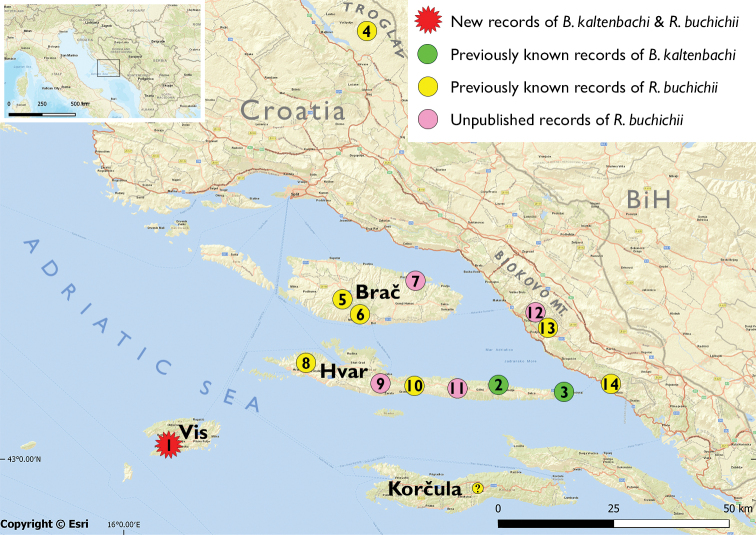
Distribution of the only known endemic bush-crickets (Tettigoniidae) of Croatia: Barbitistes
kaltenbachi (localities 1–3) and Rhacocleis
buchichii (localities 1, 4–14, ?) 1 new records from Vis Is., Mt. Hum (present paper) 2 Hvar Is., Likova Glava, Bogomolje (present paper; Warchałowska-Śliwa et al. 2013; Rebrina 2014) 3 Hvar Is., Sućuraj (present paper; Rebrina 2014) 4 Velika Greda, Troglav Mt. (Skejo et al. 2018) 5 Brač Is., south of Nere-žišća (Werner 1919) 6 Brač Is., Vidova Gora Mt. above Bol (Puskás et al. 2018) 7 new record from Brač Is., valley near Pučišća (present paper, leg., coll. KGH, 31 May 2006) 8 Hvar Is., Brusje (Novak 1888; Ramme 1951) 9 new record form Hvar Is., Pitve and Vrisnik (leg. R. Kleukers, 13 Aug. 1996, NBC) 10 Hvar Is, Mt. Humac (Novak 1888) 11 new record Hvar Is., between Jelsa and Gdinj (present paper, leg., coll. KGH, 25 Jul. 1982) 12 new record from Biokovo Mt., above Tučepi (present paper, leg., coll. KGH, 28 May 2006) 13 Biokovo Mt. (Wagner 2015) 14 Zaostrog (Gausz 1970) "?" presence on Korčula Is. has never been confirmed (Harz 1969).